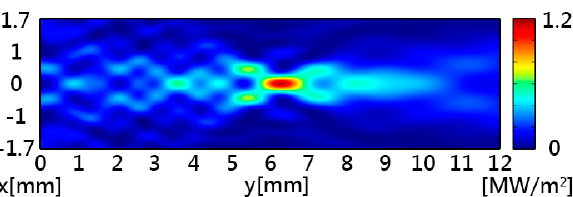
Figure 2. Simulated acoustic intensity of the acoustic tweezers. The highest intensity of 1.15 MW/M 2 is at about 10 λ focal length in the y-direction.